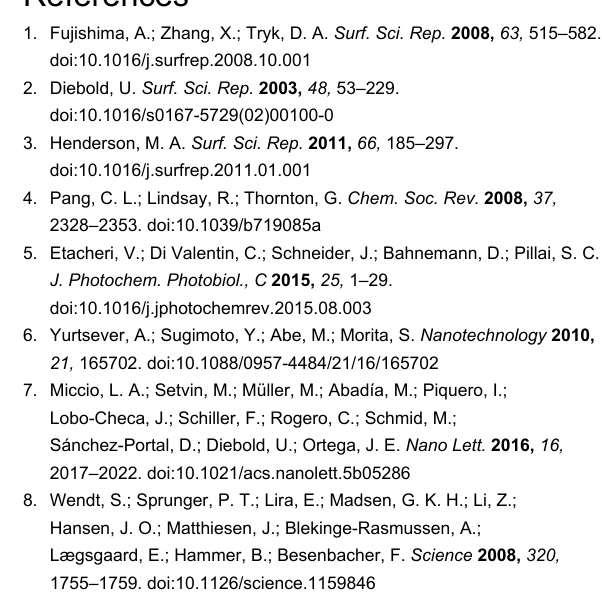
quantum yield for the chemical reaction, and enhancing the cat- alytic reactivity. These results demonstrate novel properties of steps regarding the charge distribution, except for low coordina- tion. The proposed dipole model should not be unique to TiO 2 and should be valid for other catalytic materials. Therefore, this study provides insight into the important role of the steps in cat- alytic